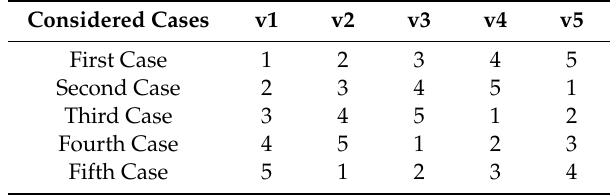
Table 2. The five considered cases for manually set query image